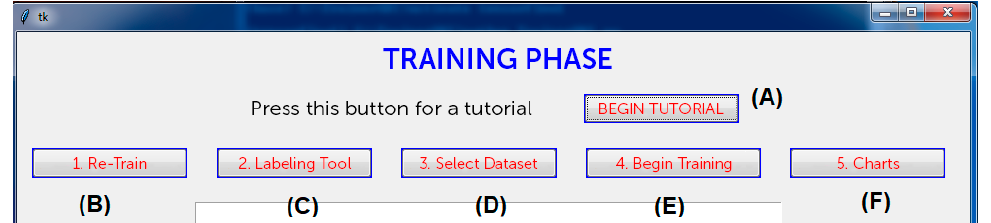
Figure 7. The prototype of an interactive user-interface for the propose system (functions described with characters A–F in brackets).